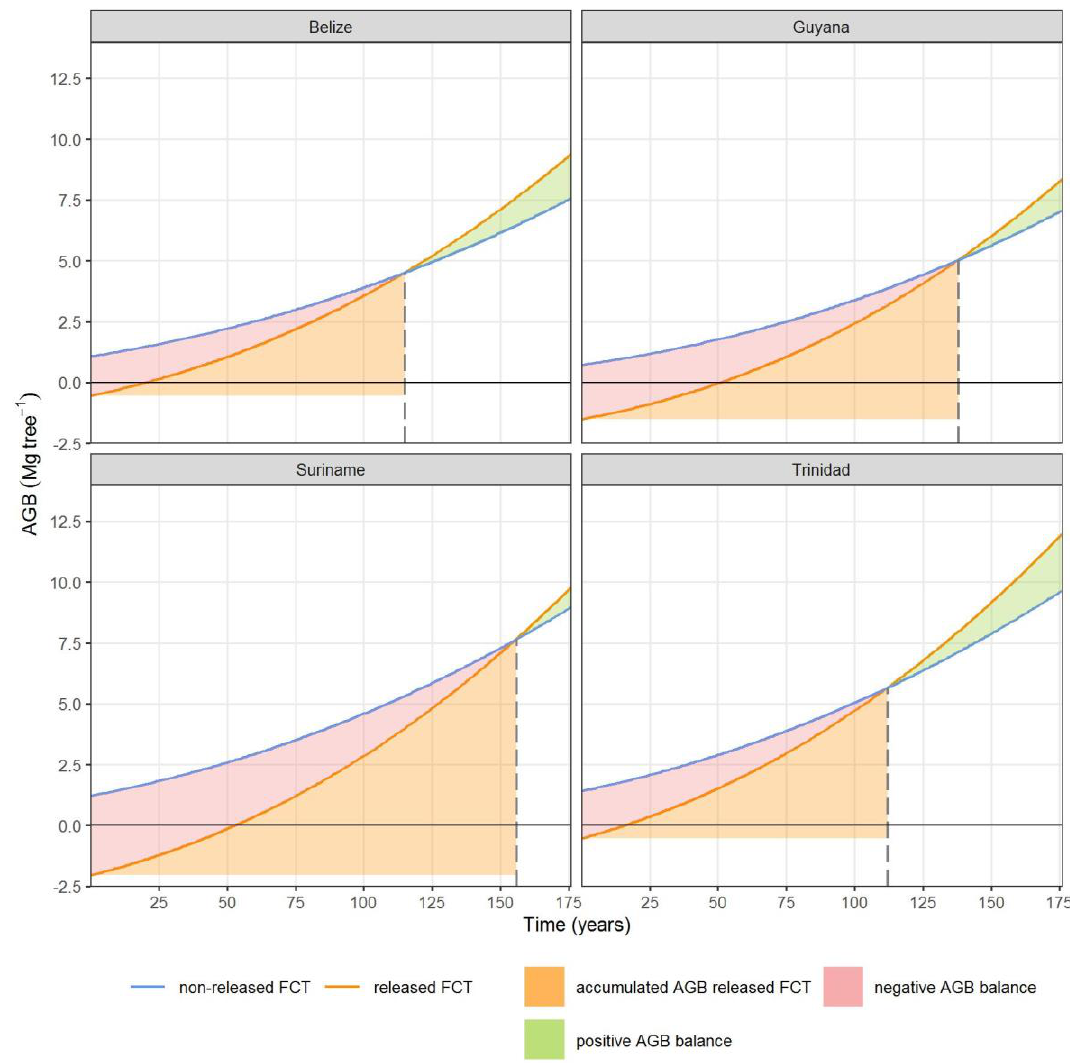
Figure 2. Above ground biomass (AGB) growth simulation by country of released and non-released FCTs.